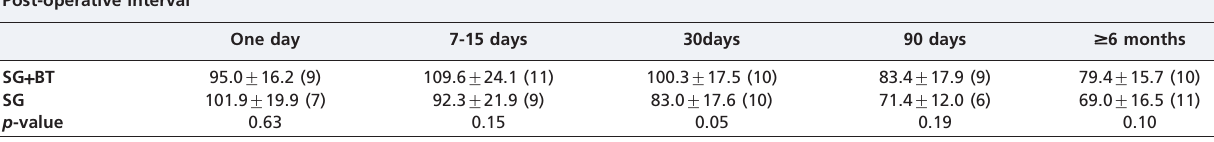
Table 3 - Percent net changes in the postoperative